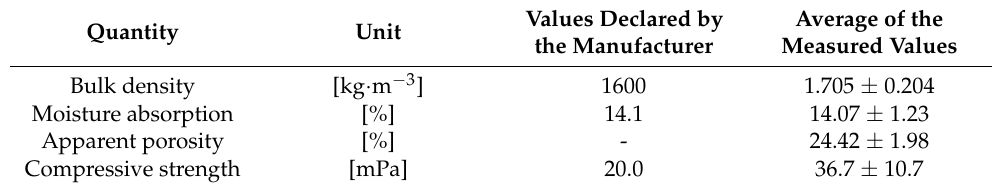
Table 2. Overview of the physical properties of the ceramic solid burnt brick samples.